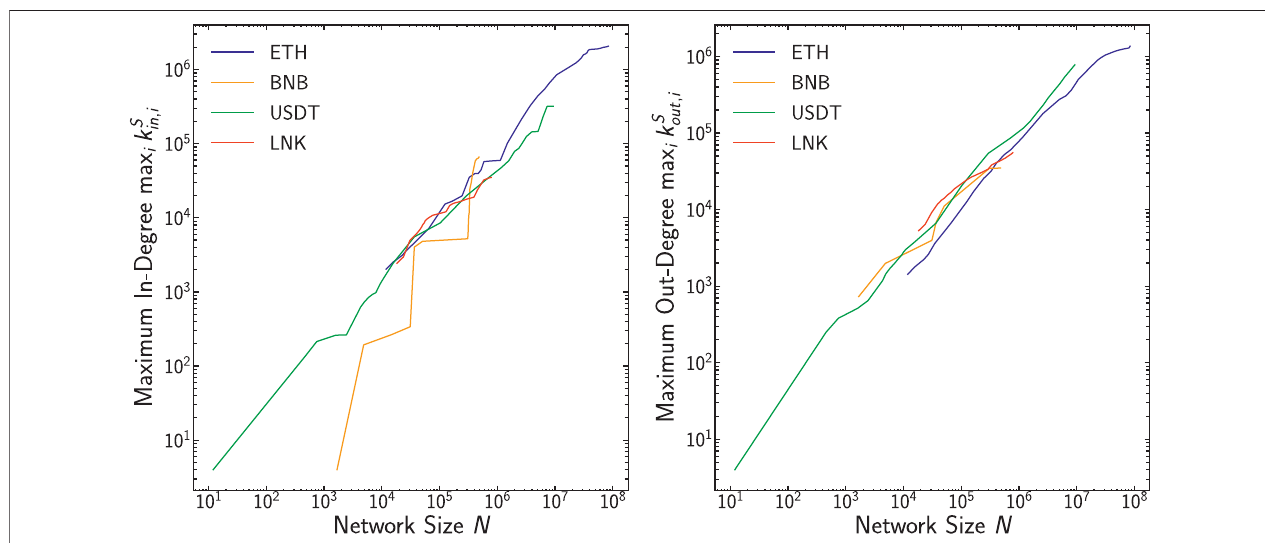
FIGURE 11 | We plot the maximum in-degree max i k S in , i (A) and maximum out-degree max i k S out , i (B) as a function of the network size N . The measurements are performed on a monthly basis.